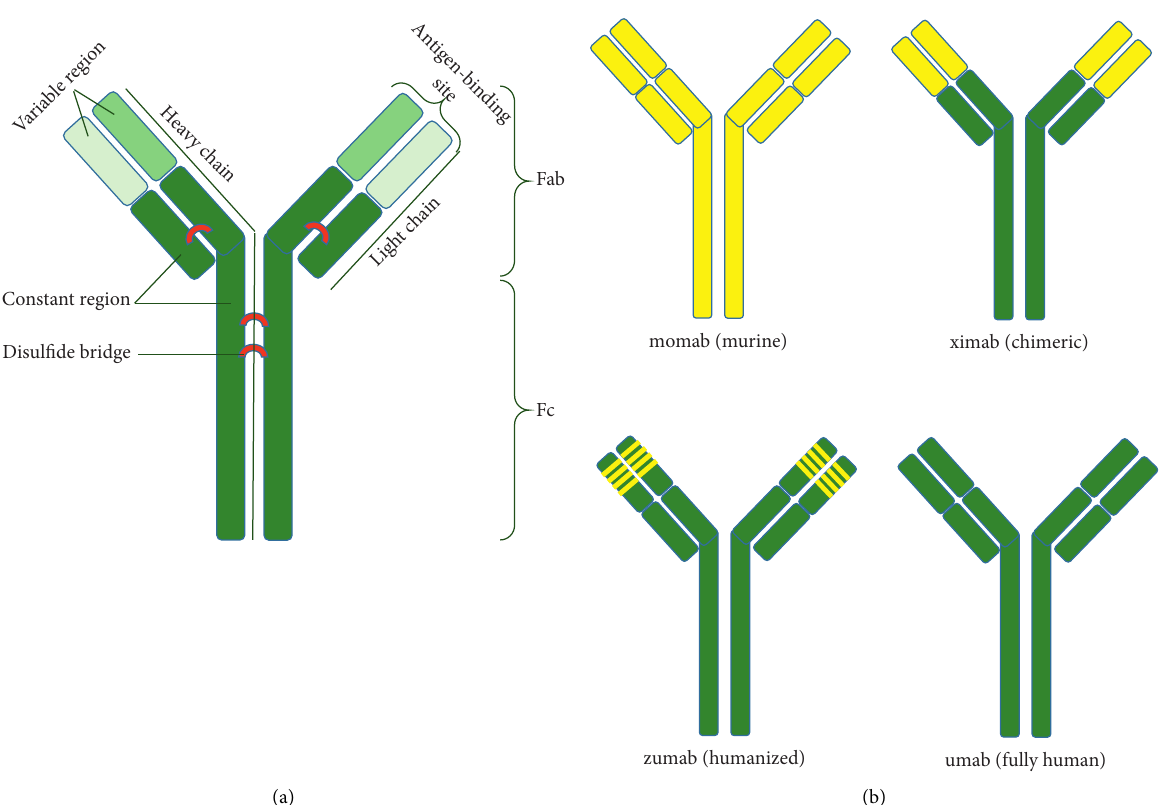
Figure 1: (a) A schematic representation of the antibody structure. (b) Various monoclonal antibodies based on different origins. Yellow parts show the murine-based source, and green parts show human-based